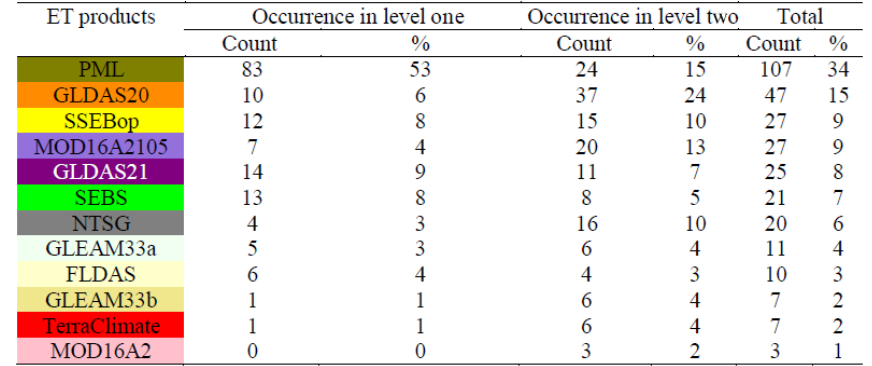
Table 6. The occurrence of the 12 ET products based on Table 5.